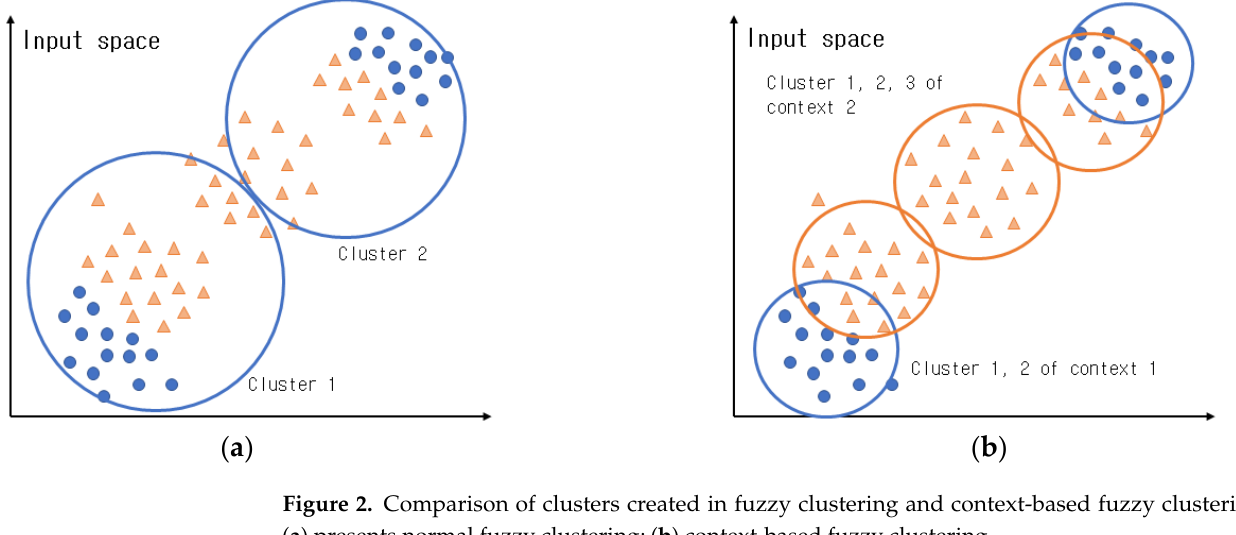
Figure 1. Context-based fuzzy clustering and interval-based fuzzy clustering concept: ( a ) context- based fuzzy clustering; ( b ) interval-based fuzzy clustering.